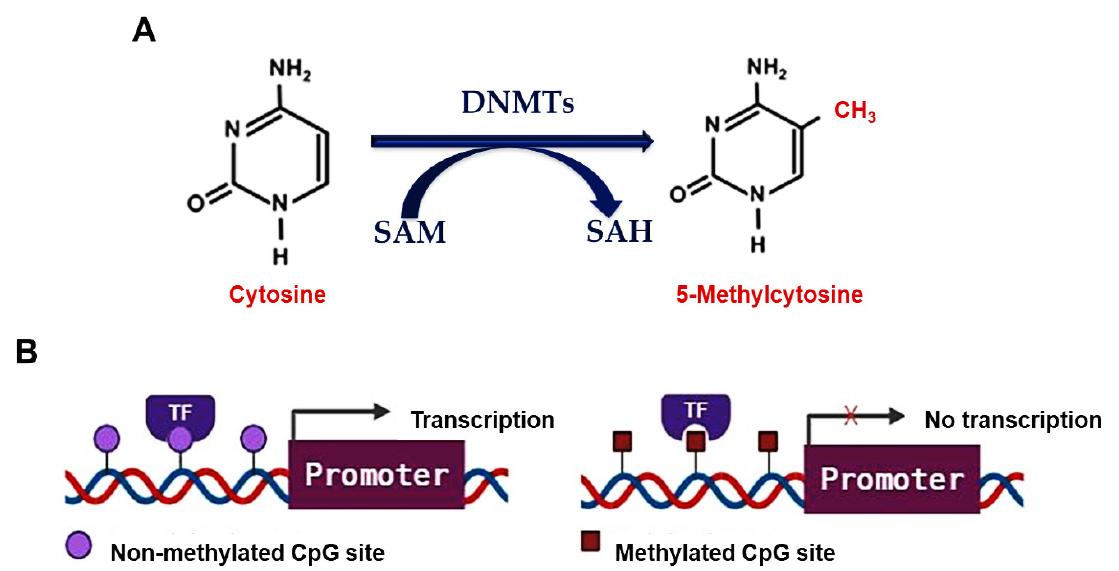
Figure 2. DNA methylation and gene expression regulation. ( A ) Process of DNA methylation. DNMTs covalently add a CH 3 group from SAM to the number 5 carbon of cytosine bases yielding 5-methylcytosine and SAH. ( B ) Gene expression regulation by DNA methylation. DNA hypomethylation (non-methylated CpG site) enables TF to bind to gene promoters and activate its transcription; however, DNA hypermethylation (methylated CpG site) prevents the binding of TF to gene promoters and inhibits gene transcription. Abbreviations: CH 3 : methyl group; CpG: cytosine bases preceding guanine bases; DNMTs: DNA methyltransferases; SAM: S-adenosylmethionine; SAH: S-adenosylhomocysteine; TF: transcription factor. Created with BioRender.com.